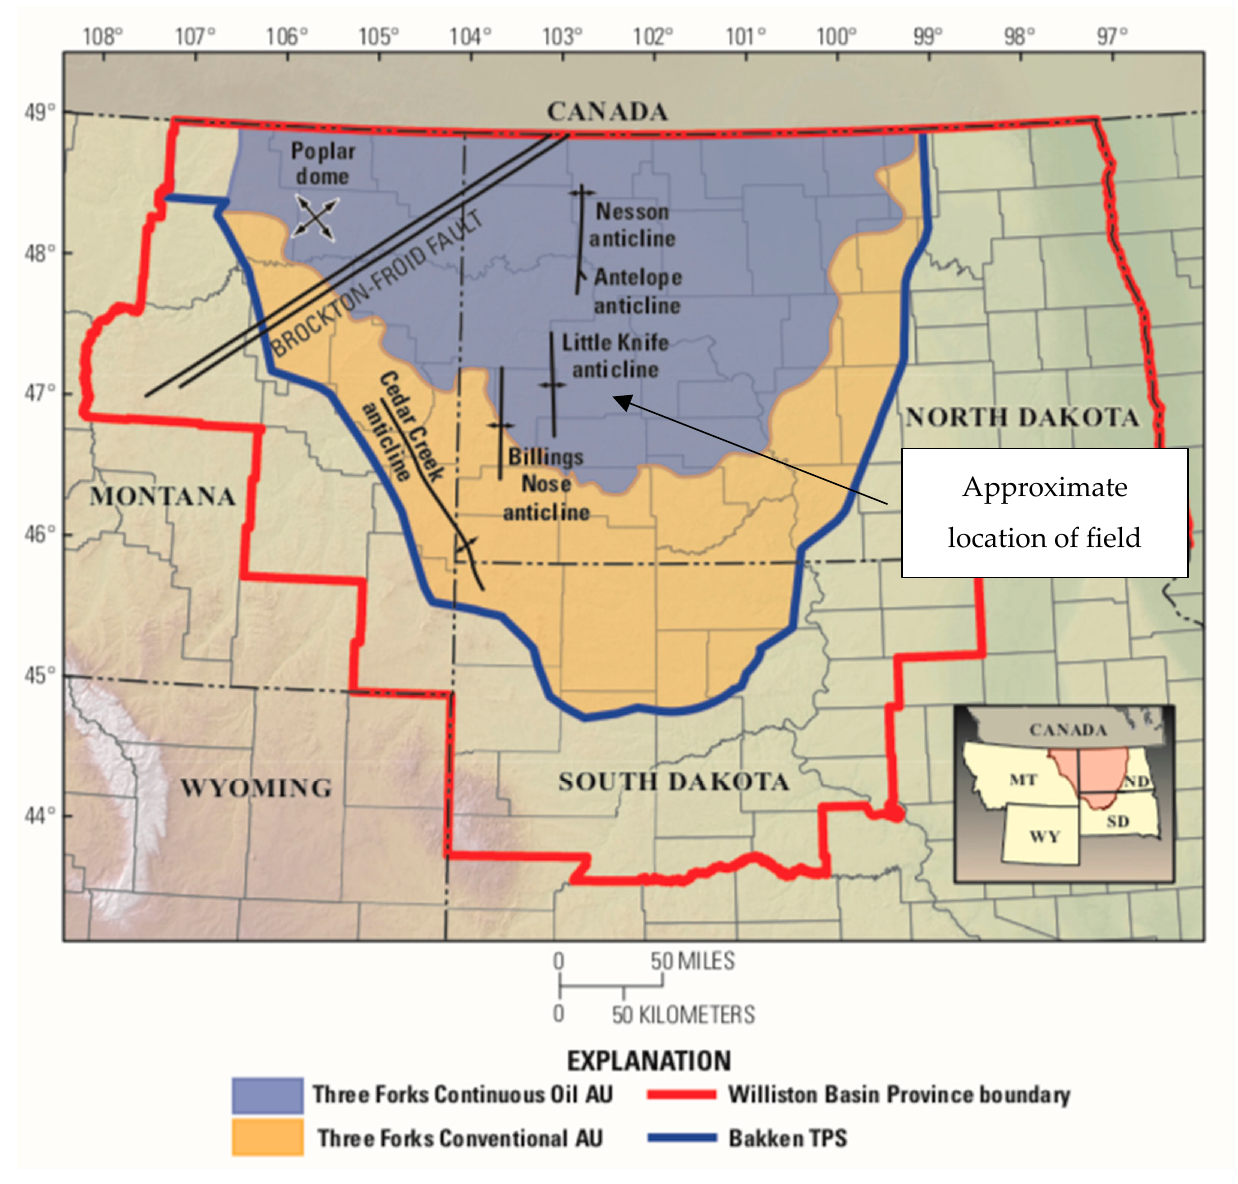
Figure 2. Location map [20]. Table 1. Summary statistics for the re-fracturing data set assuming a pooled model